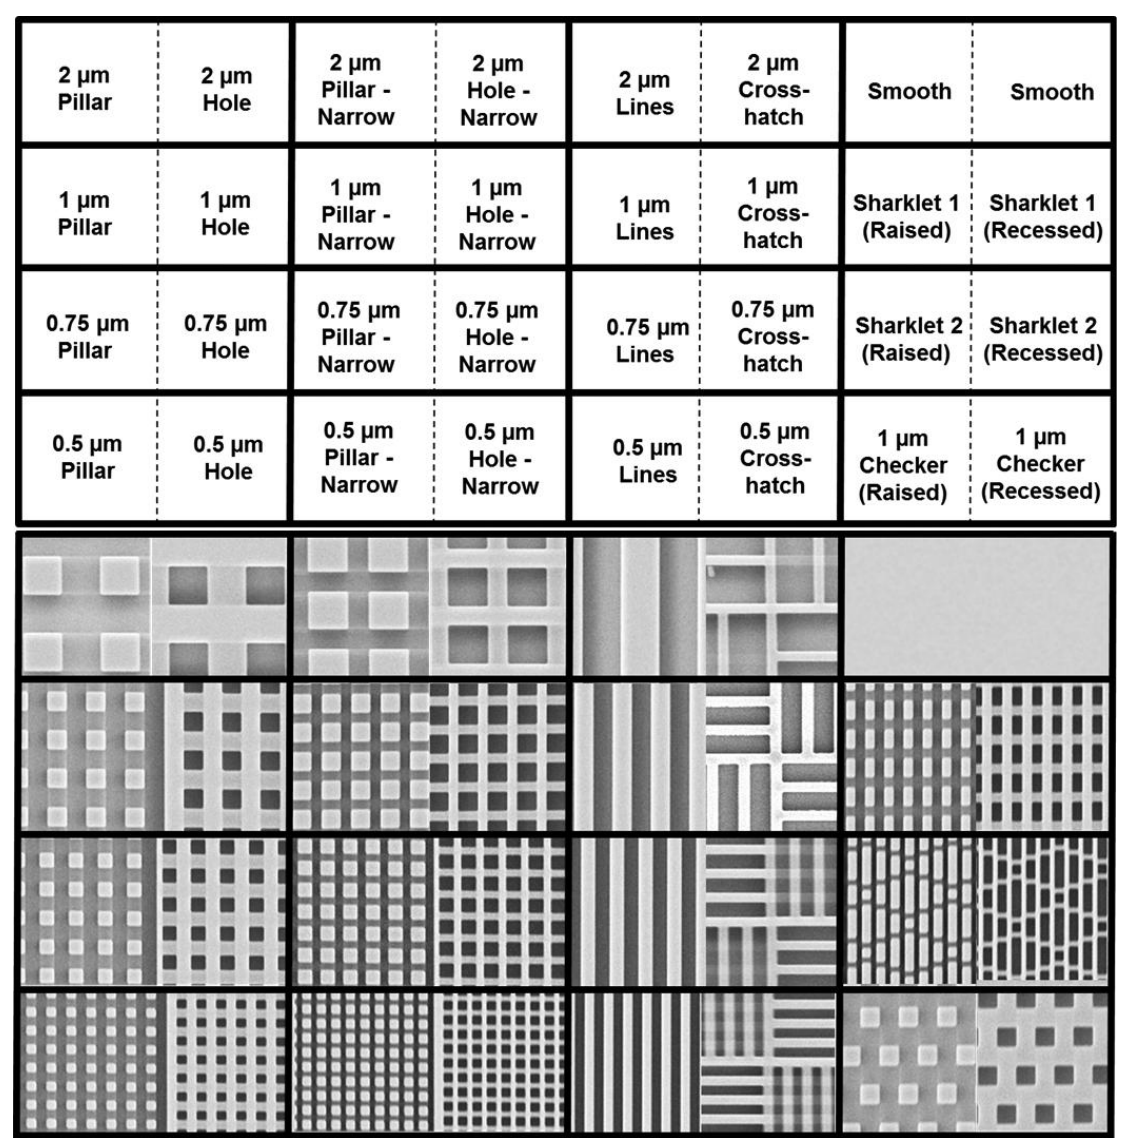
Figure 4. Microscale and sub-micron topography for antifouling studies (from Ling et al . [53] with permission of World Scientific Publishing Company ©